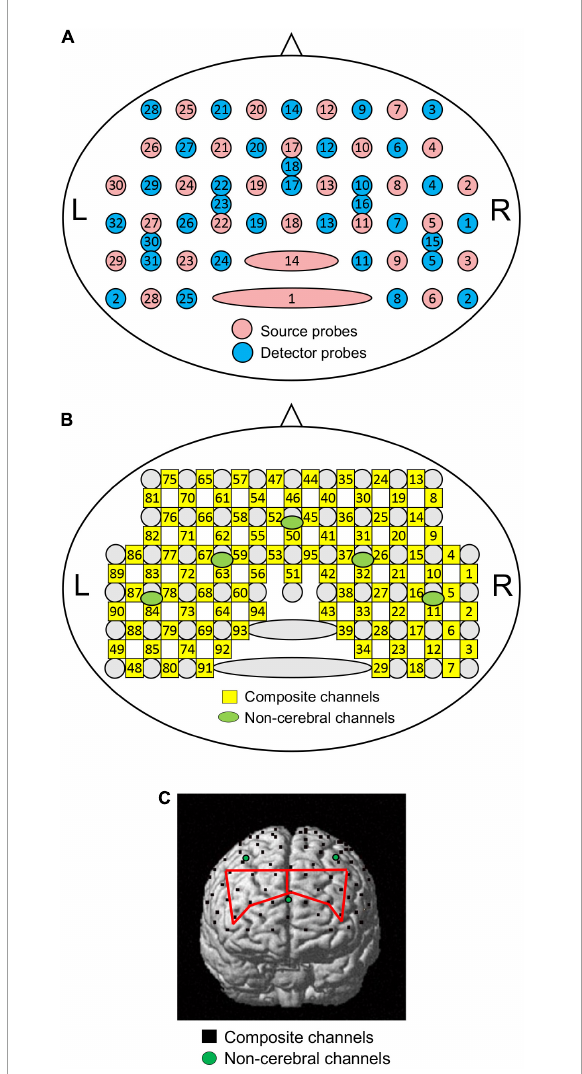
FIGURE1 Schematic presentation of NIRS probe and channel locations. (A) Arrangement of source and detector probes in a NIRS head cap. Numbers in red and blue circles indicate source and detector numbers, respectively. L, left; R, right. (B) Arrangement of NIRS channels. Numbers in green circles indicate composite channel numbers; numbers in green circles indicate non-cerebral channel numbers. (C) Identification of NIRS channel locations in one participant. Black dots indicate composite channels; green circles indicate non-cerebral channels. Regions of interest (ROIs) [the right and left dorsolateral prefrontal cortices (dl-PFC) are indicated by red